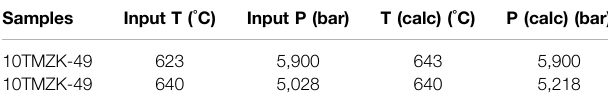
TABLE 6 | Calculation results of the amphibole pressure and